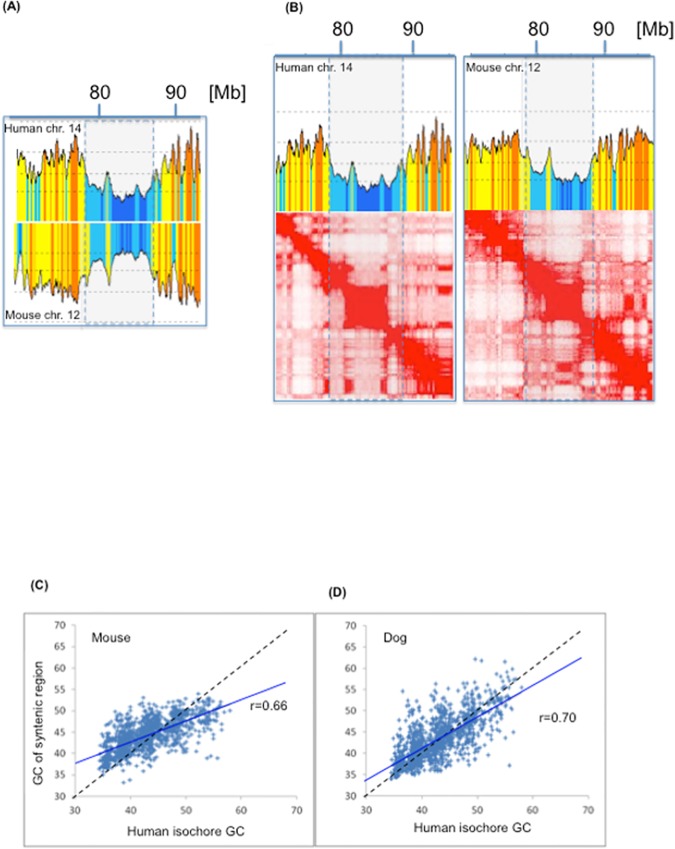
Evolutionary conservation of TADs and isochores.(A) The compositional profiles of two syntenic regions located on human chromosome 14 and mouse chromosome 12 (from [3, 8] respectively) are almost mirror images of each other, showing the compositional conservation of syntenic regions in evolution. (B) A comparison of compositional profiles and heat maps (from [3]) of the two syntenic regions from panel A. (C and D) GC levels of 1,348 and 1,358 syntenic regions from mouse (left) and dog (right) are plotted against the GC levels of human isochores.